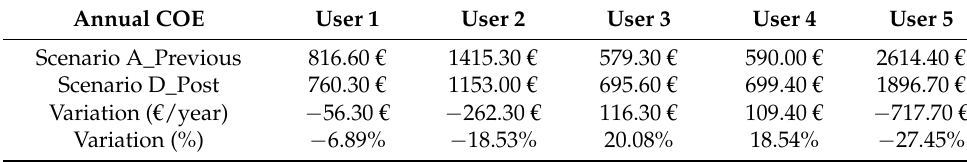
Table 6. Previous and current annual costs of energy (COE).